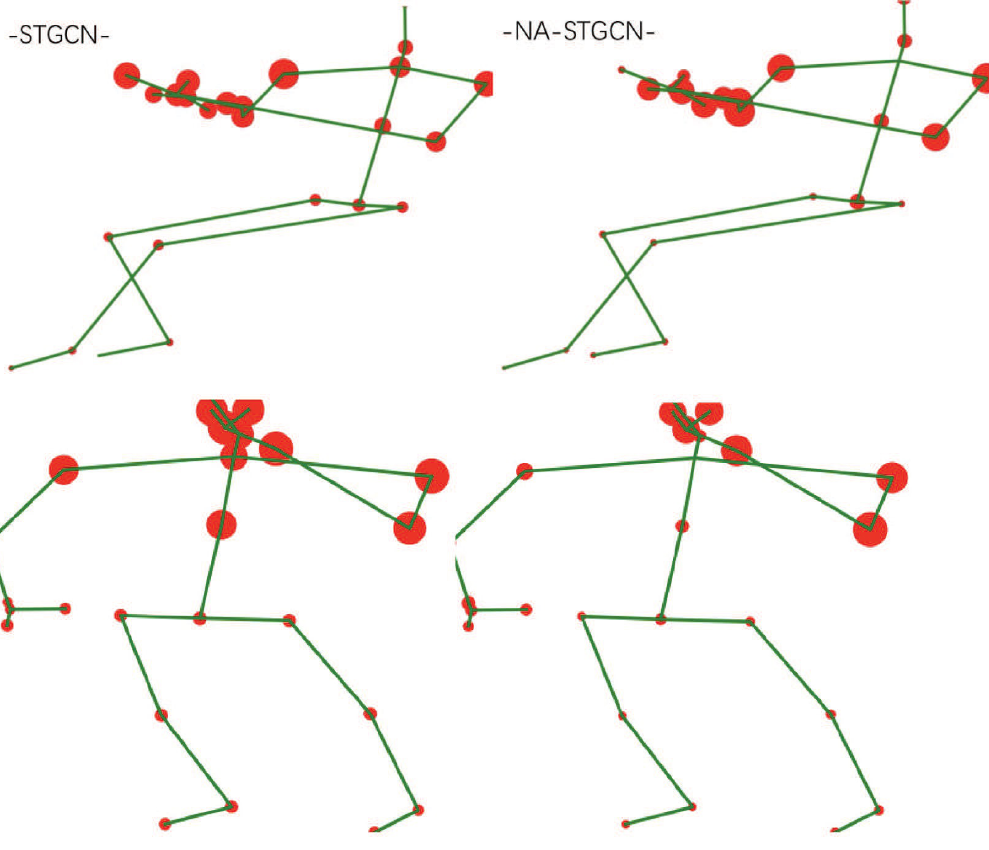
Fig. 4 Node activation response maps: (a) top left: ST-GCN clapping action; (b) top right: NA-STGCN clapping action; (c) bottom left: ST-GCN brushing action; (d) bottom right: NA-STGCN brushing action. NA-STGCN, node